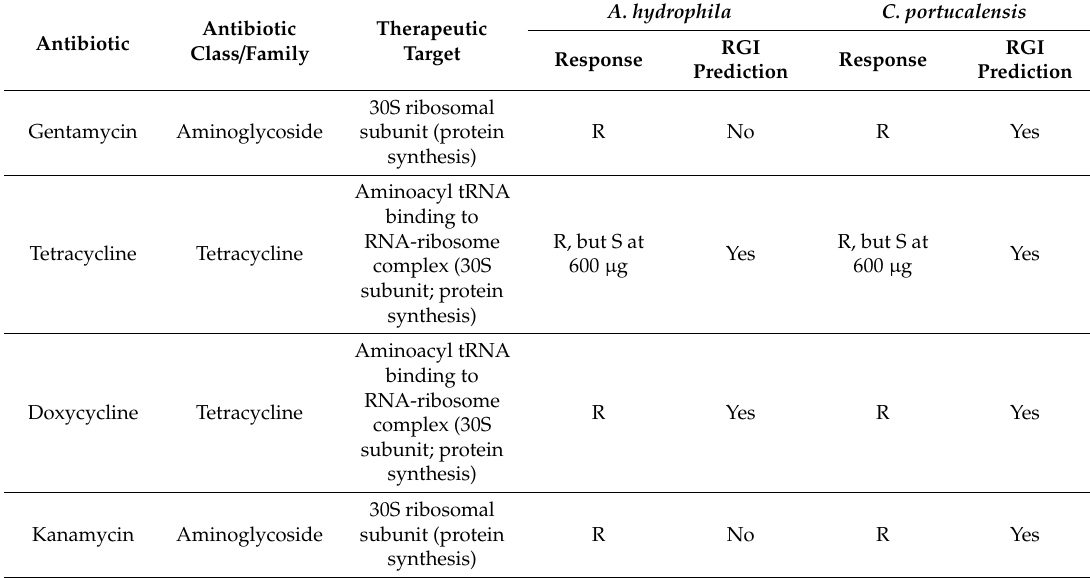
Table 3. Antibiotics used in this study (Kirby–Bauer disc di ff usion) for A. hydrophila and C. portucalensis their drug classes and therapeutic targets. R = resistant, and S = susceptible. Resistance Gene Identifier (RGI) [94] predicts resistance based on the genome information; Yes = resistance predicted; No = resistance not predicted. The predictions are drawn from published data